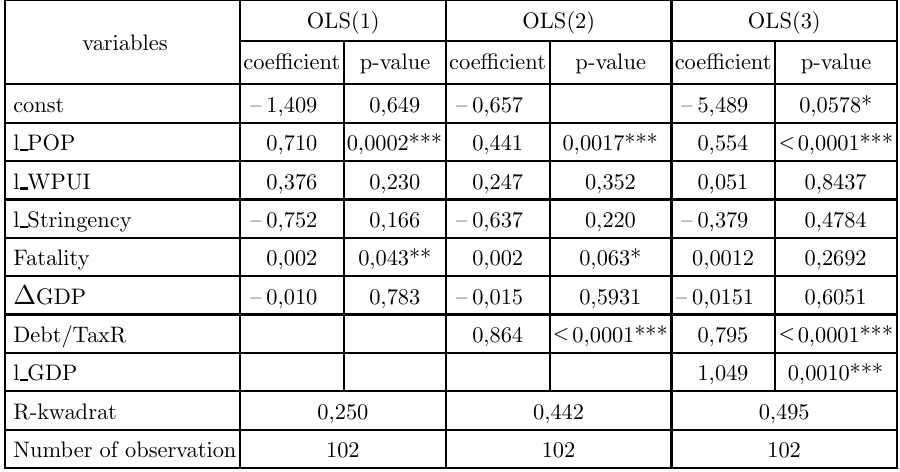
Pooled OLS. Fiscal response in response to the COVID-19 pandemic OLS(1) OLS(2) OLS(3) variables coefficient p-value coefficient p-value coefficient